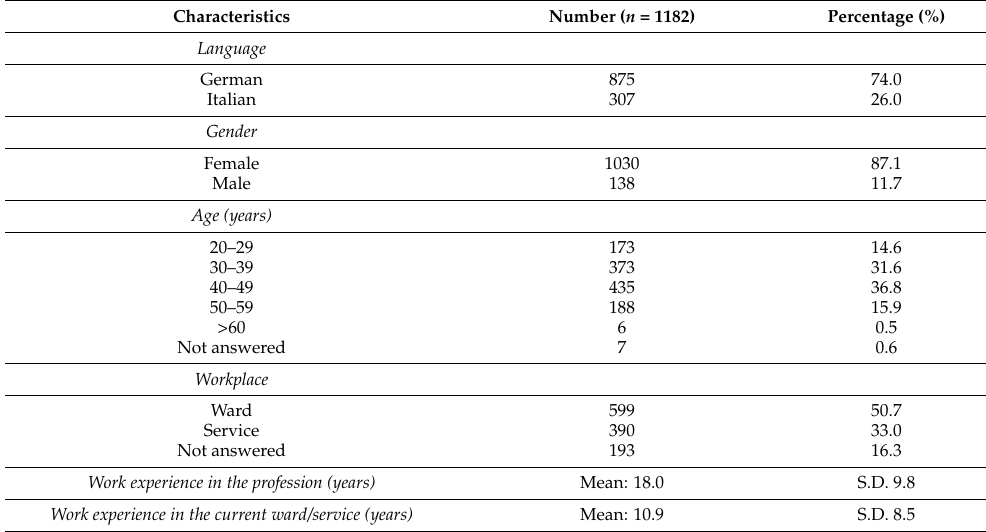
Table 2. Characteristics of the